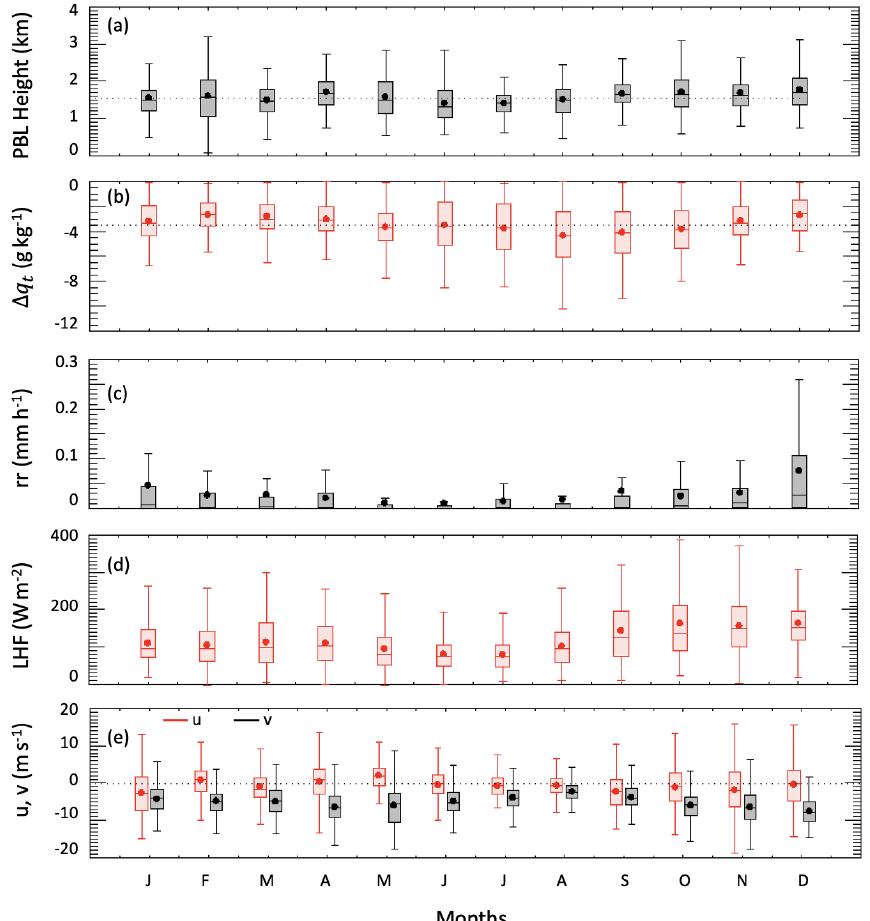
Figure 3. Monthly box and whisker values of (a) PBL height, (b) humidity gradient at the boundary layer top, (c) rain rate, (d) latent heat fluxes, and (e) zonal ( u ) and meridional ( v ) components of the wind. Dotted lines represent the annual mean in (a) and (b) and the zero line in (e) .